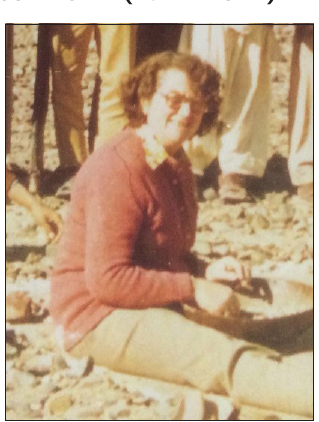
Figure 1: Bridget Allchin in the field (Photo Allchin